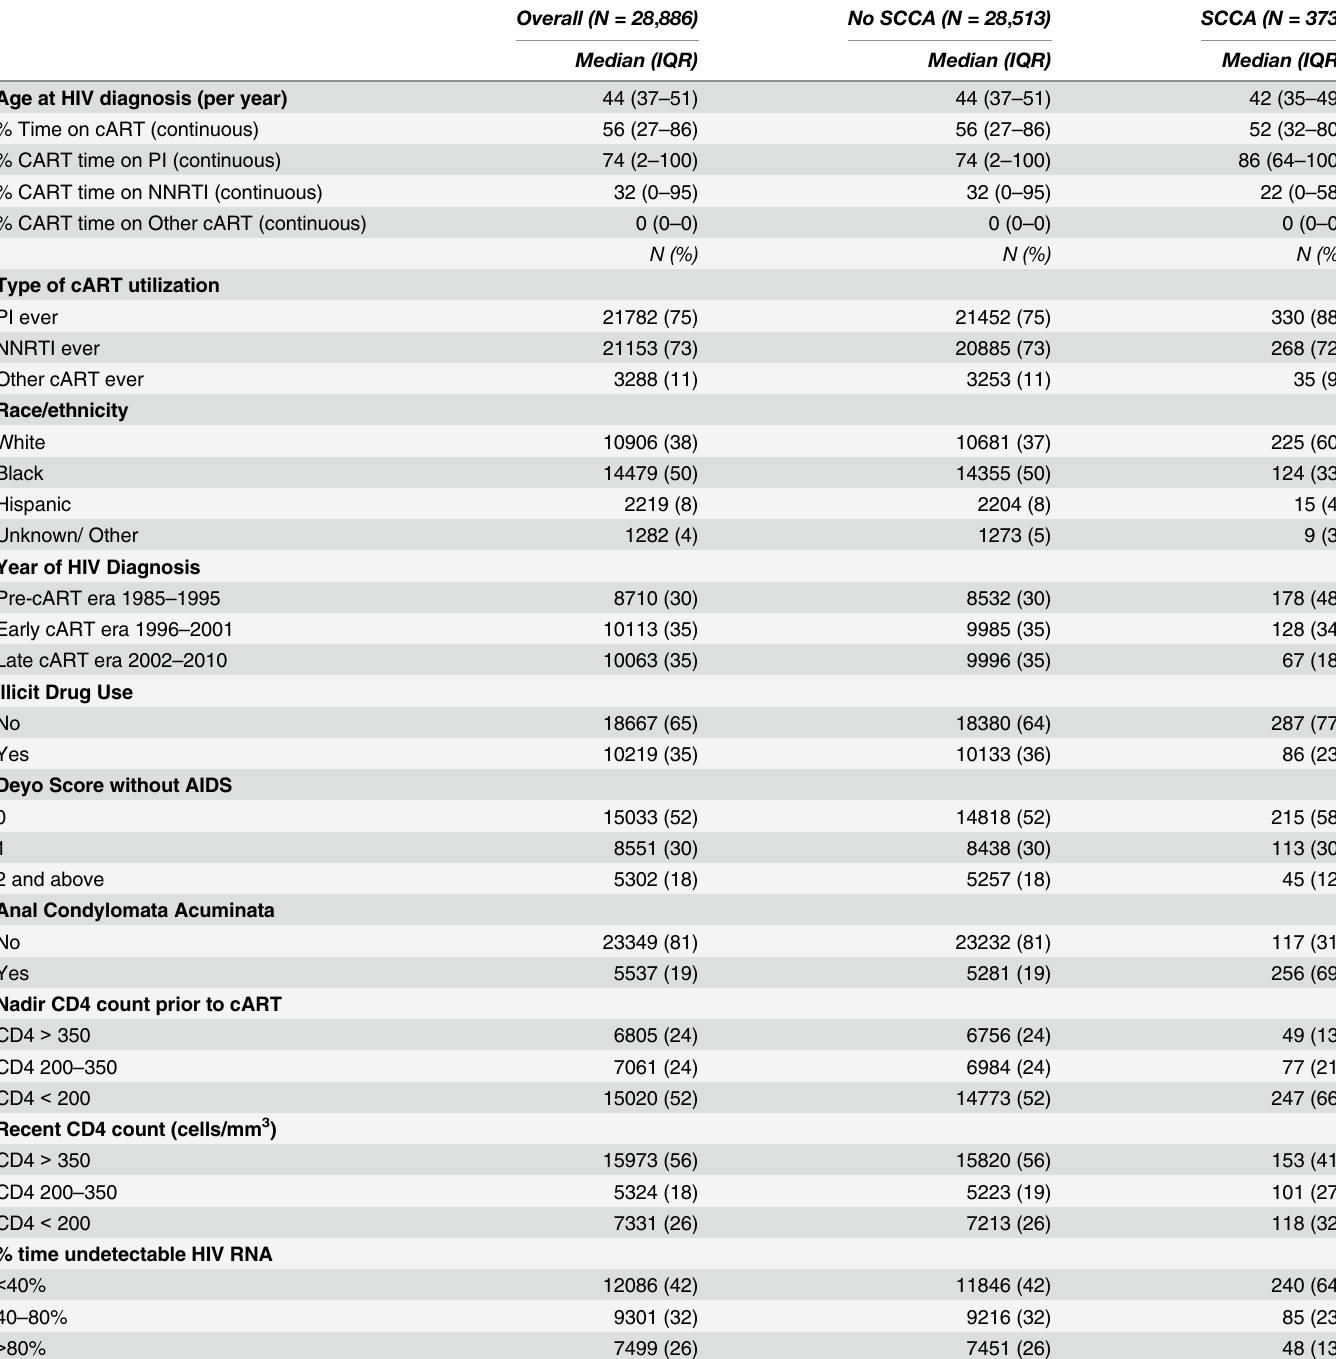
Table 1. Population Characteristics, Overall and by Squamous Cell Carcinoma of the